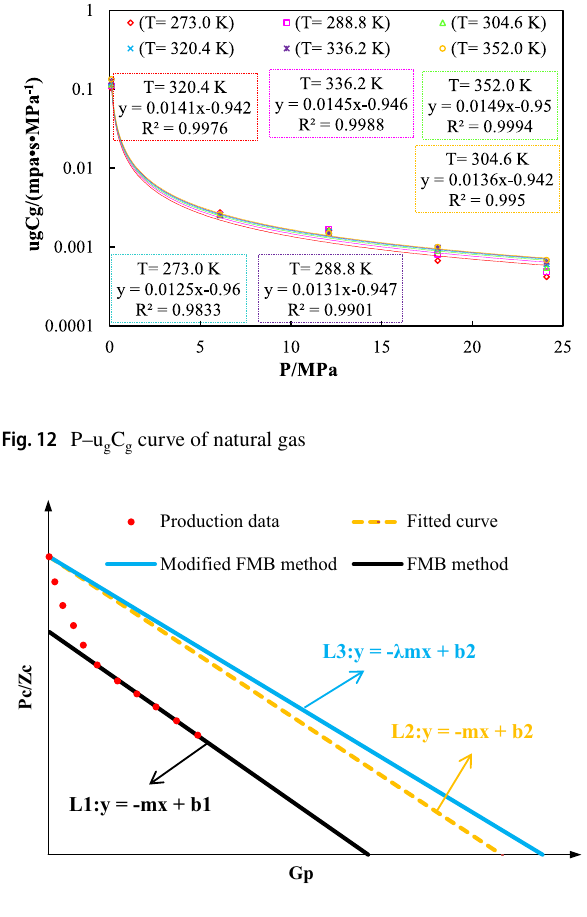
Fig. 13 Process of modified FMB